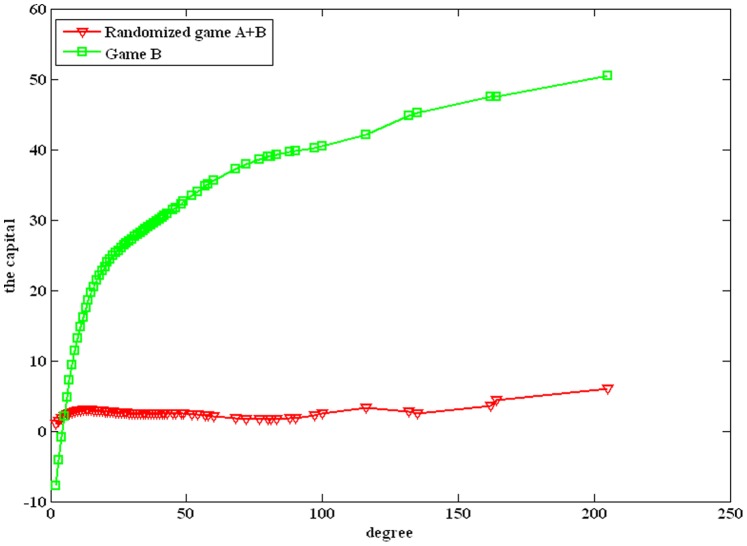
The relationship between the degree and the capital (based on the BA scale-free network).The population size N is 10, 000. The average degree of the network is four and the average number of playing times T of each individual is 100. The probability of playing game A is p = 0.5. The probabilities of winning in branch one and branch two of game B are p
1 = 0.175 and p
2 = 0.870, respectively. Play the games 1000 times with different random numbers, and draw the corresponding figures according to the average results of the games. For the nodes with the same degree, the capital is averaged from all of these nodes.